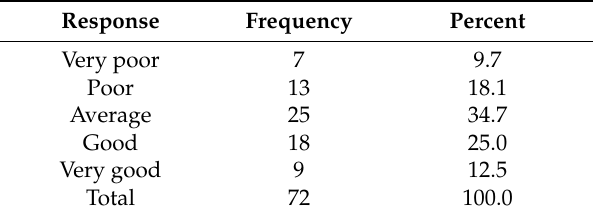
Table 4. The response on the rating of service offered by the Zimbabwe Republic Police